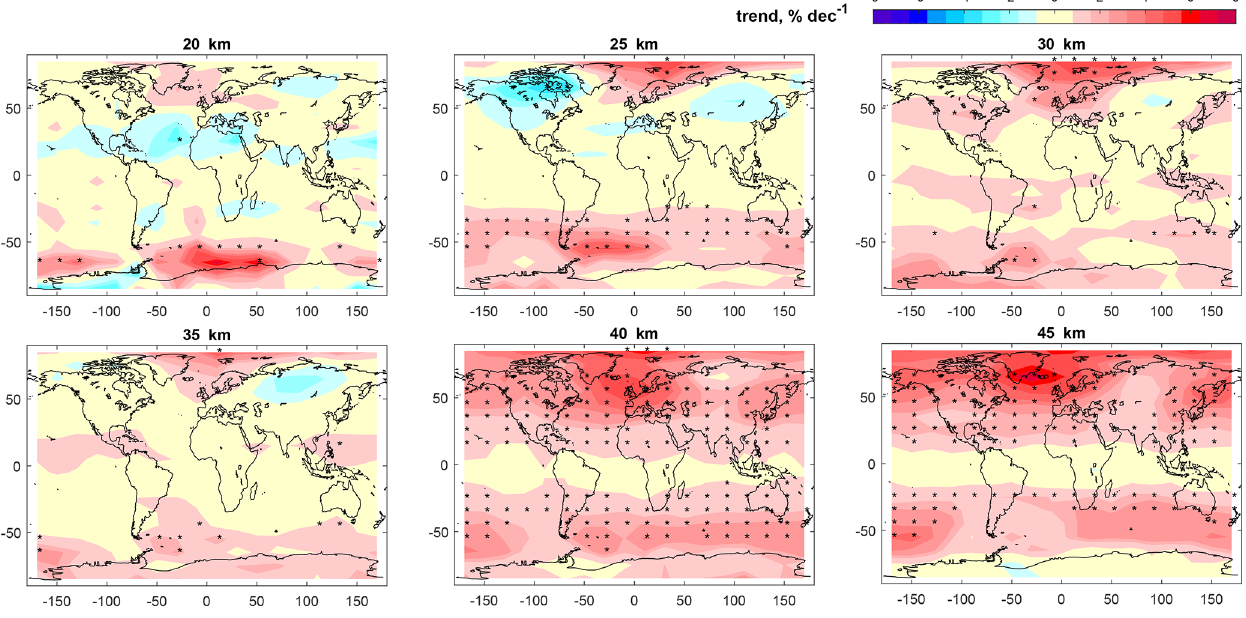
Figure 11. Same as Fig. 10, but for trends in DUkm − 1 decade − 1